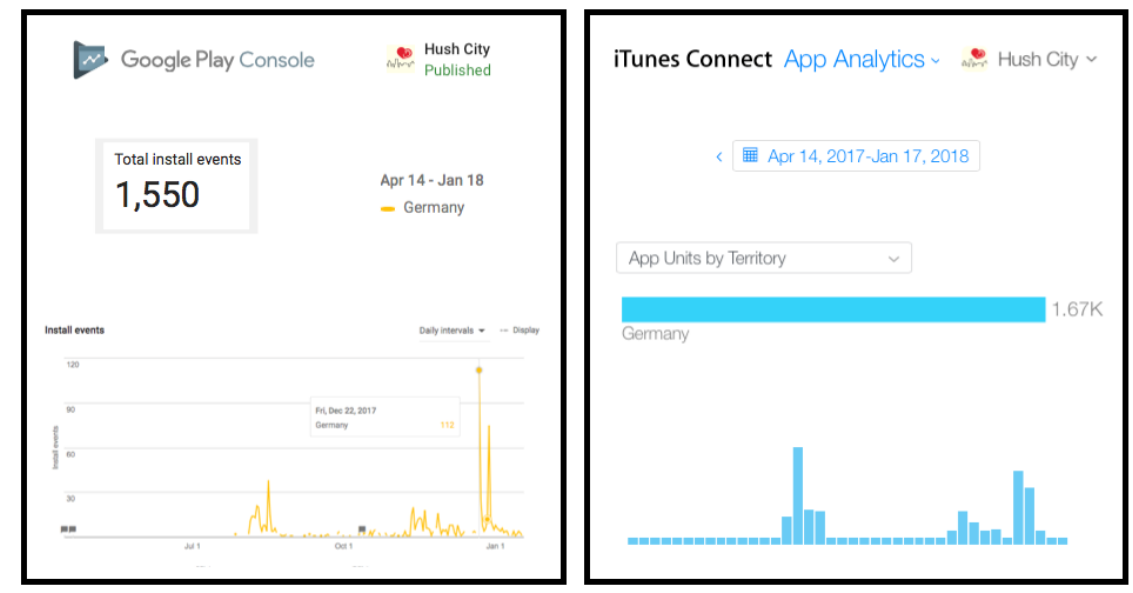
Figure 11: Analytics showing the number of install events & app units in Germany, both for iOS and Android. Installation’s peaks correspond to the times in which the Hush City app received extensive press coverage © A. Radicchi